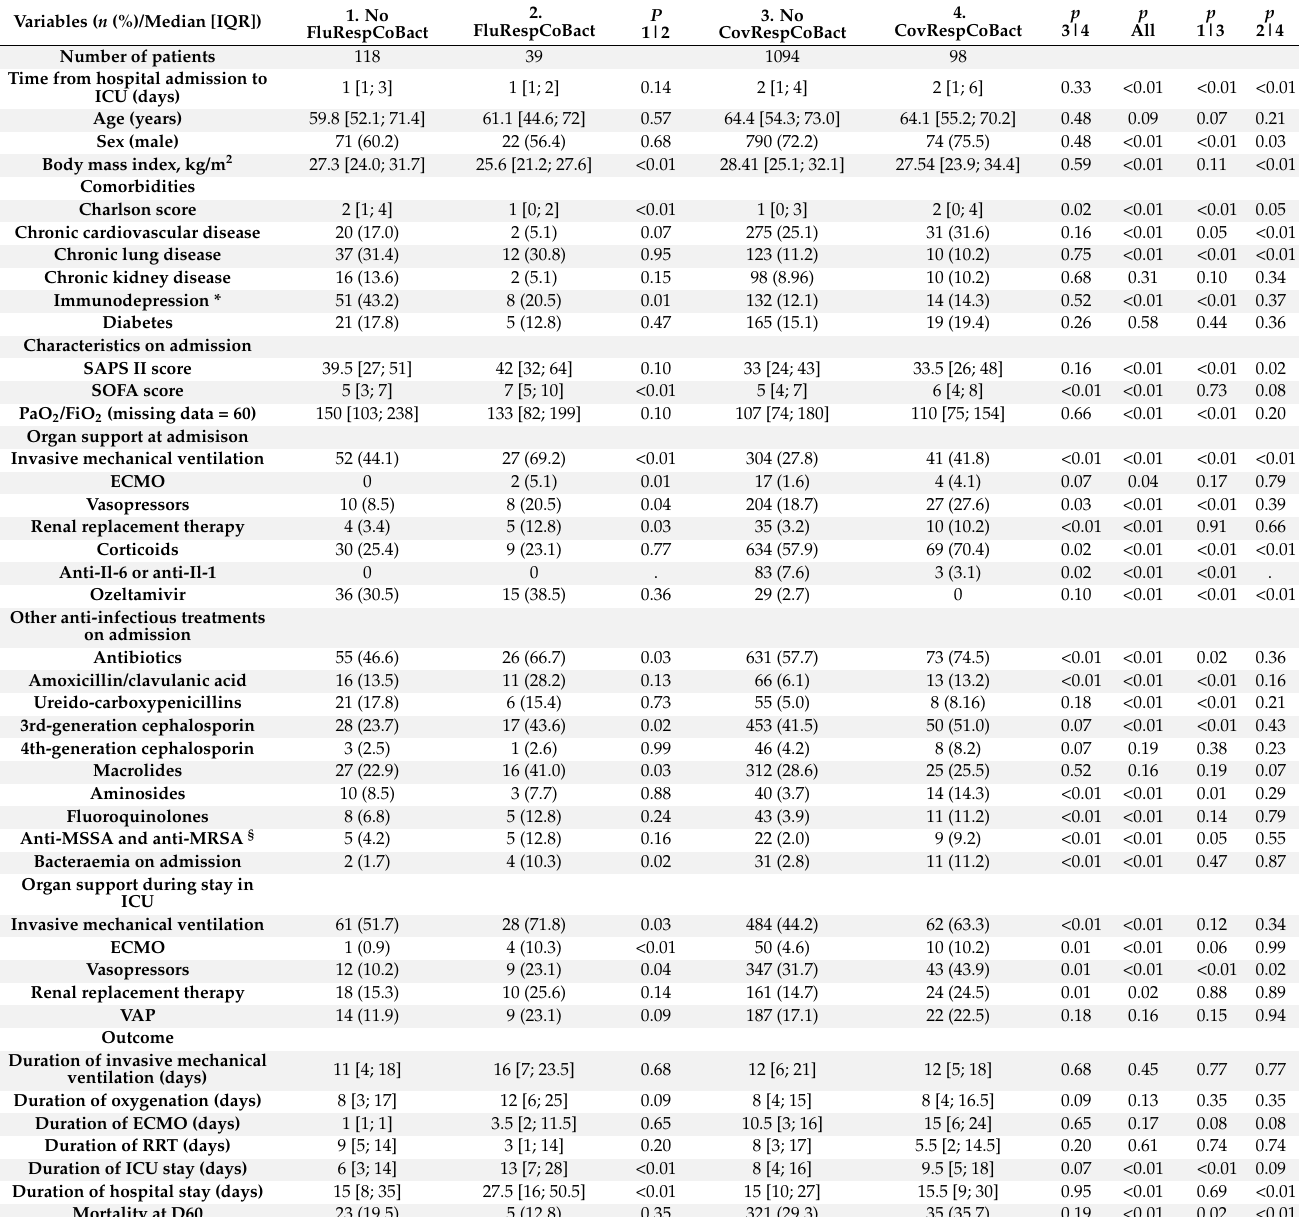
Table 2. Comparison of patients with influenza or SARS-CoV-2 pneumonia with and without respiratory bacterial co-infection on